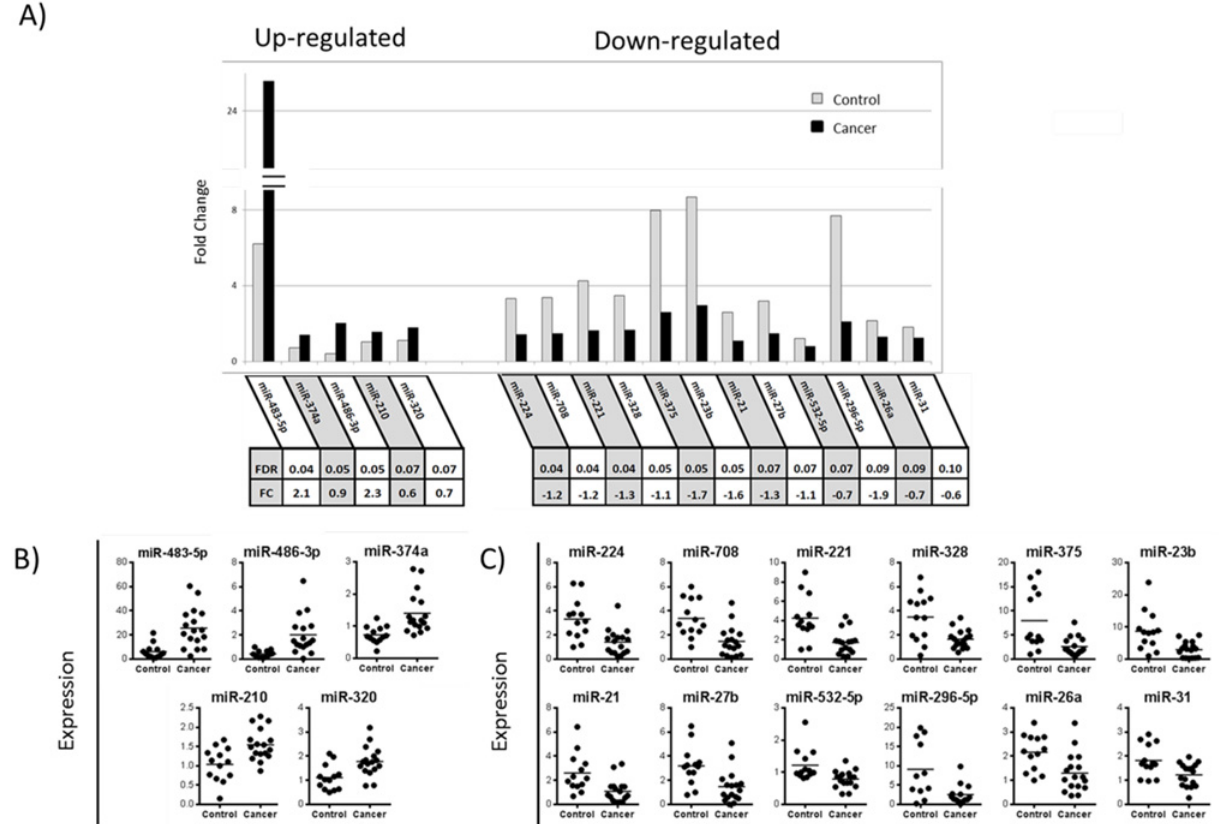
Fig 3. MicroRNA expression in the peripheral airway epithelial cells. A) Using TaqMan miRNA Array, 5 miRNAs were highly (FDR < 0.1) up-regulated in peripheral airway field of cancerization of cancer patients (black bar) vs. peripheral airways of smoker controls (gray bar). 12 miRNAs (FDR < 0.1) were strongly down-regulated. MiRNA fold change is shown as the mean expression relative to a reference value. Table below shows FDR value base on Benjamini-Hochberg multiple testing and log2 fold change value of cancer patient relative to smoker control. B) Individual dot plot of cancer patients (n = 17) compared to peripheral airways of smoker controls (n = 13) with up-regulated miRNAs. C) Individual dot plot with down-regulated miRNAs.